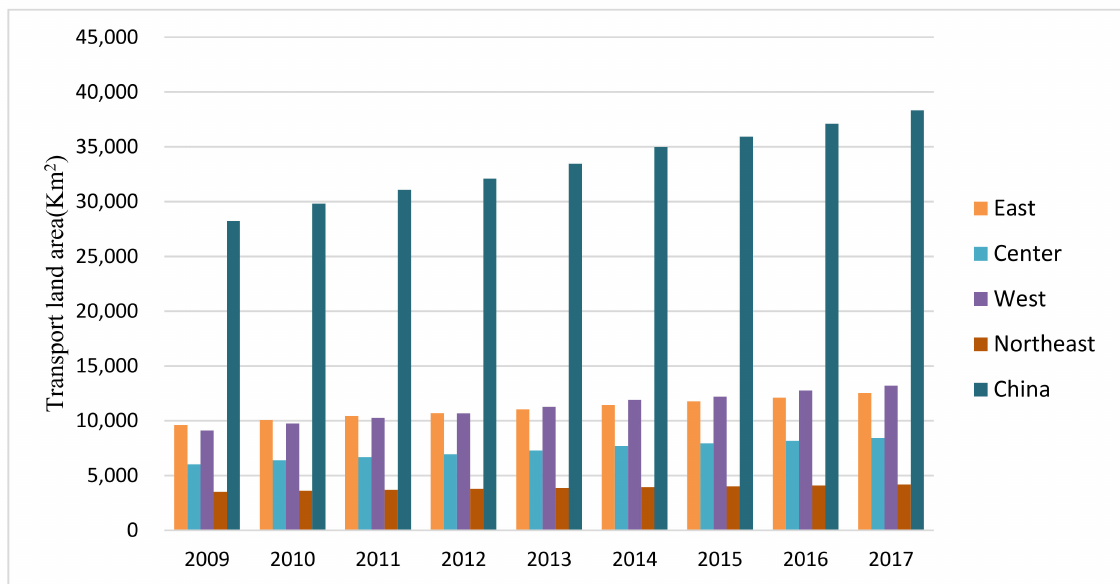
Figure 4. Evolutionary trend in transport land in the four Chinese regions from 2009 to 2017. Data source: China Land and Resources Statistical Yearbook (2015–2017) [29] and NBSC (2022)